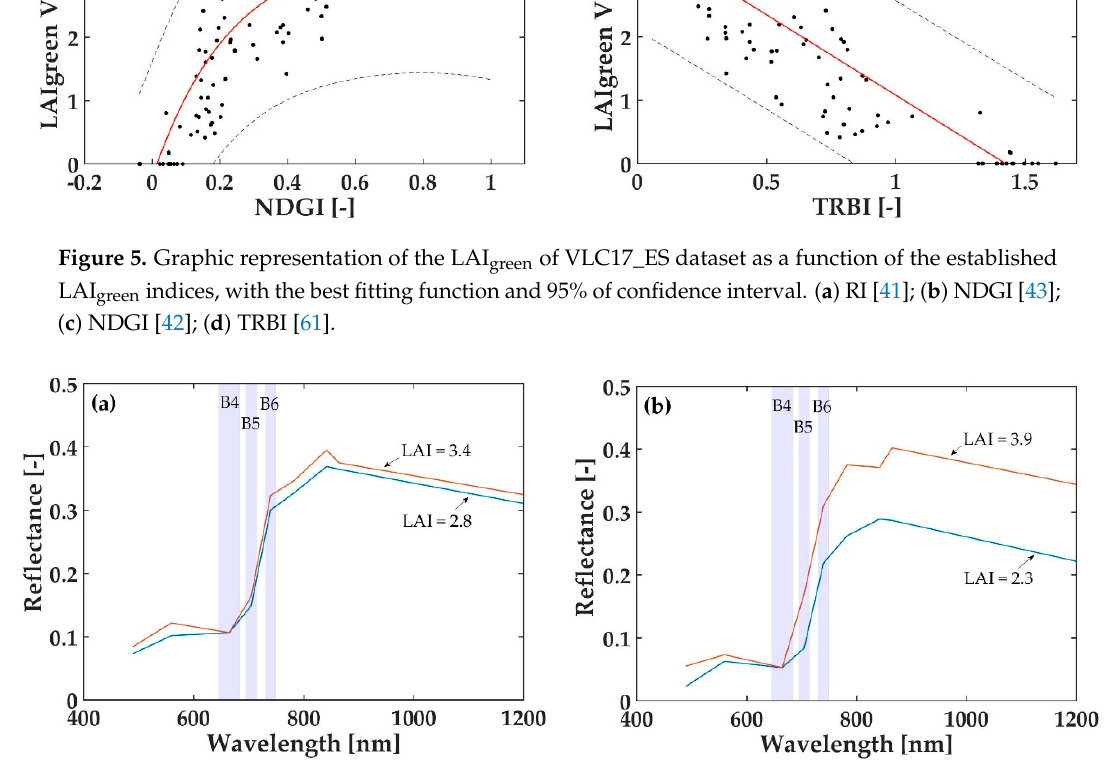
Figure 5. Graphic representation of the LAI green of VLC17_ES dataset as a function of the established LAI green indices, with the best fitting function and 95% of confidence interval . (a) RI [41]; (b) NDGI [43]; (c) NDGI [42]; (d) TRBI [61].